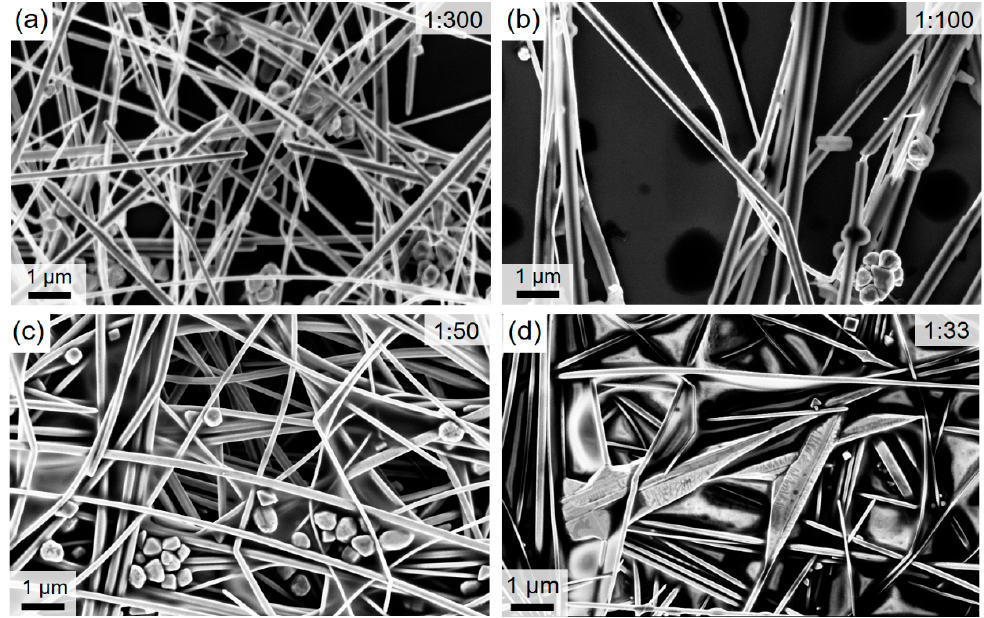
Figure 2. FESEM-images of CuNWs for the precursor-to-solvent series with different mass ratios (precursor:solvent) of ( a ) 1:300, ( b ) 1:100, ( c ) 1:50 and ( d ) 1:33.